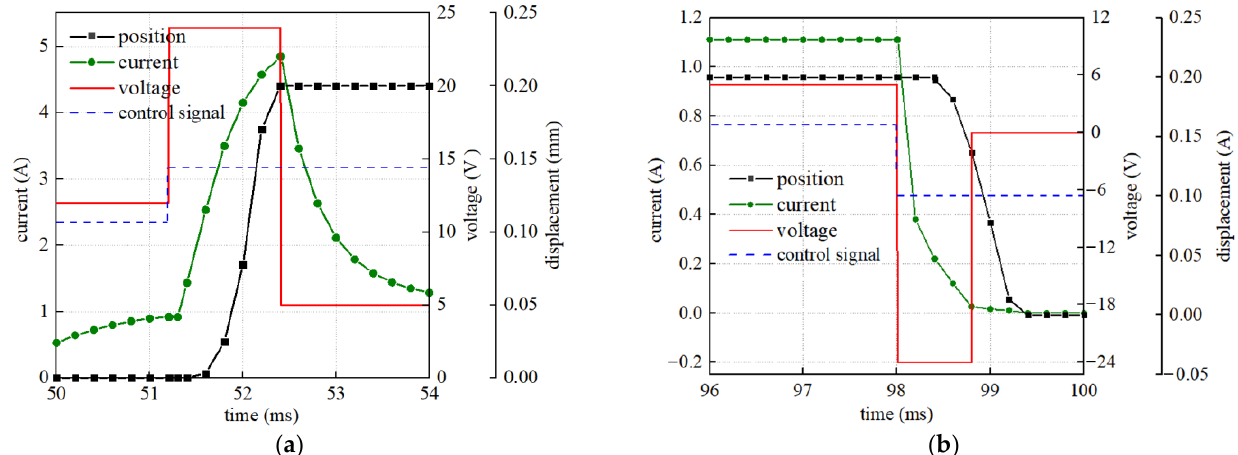
Figure 5. The dynamic characteristics’ curve in PECA: ( a ) Opening process; ( b ) Closing process. Table 1. Dynamic characteristics of the HSV in the two driven strategy .